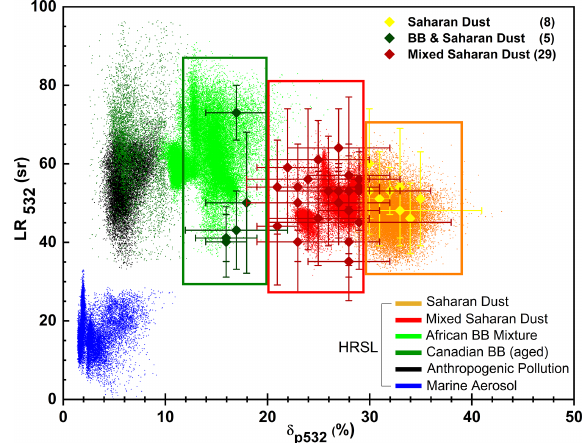
Figure 5. AE β 532 / 1064 versus AOT 532 per region: western (red marks and error bars), central (green marks and error bars) and eastern (blue marks and error bars) Mediterranean region. K - means clustering revealed three clusters: fine mode (light blue background), coarse mode (magenta background) and extreme dust events (yellow background).